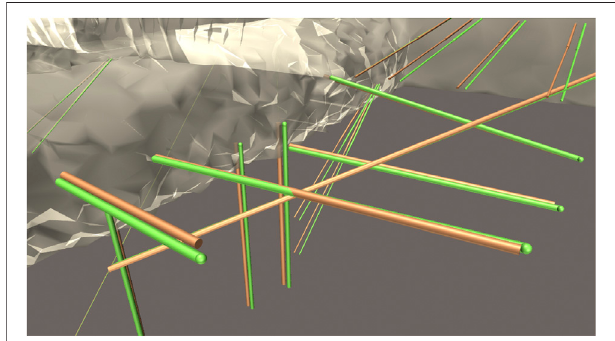
FIGURE3| Visualrepresentationoftheboreholesbasedoncalculations with single-precision fl oating-point vectors (brown) compared to double- precision (green). The green spheres are marking the actual borehole ’ s start- and end point as a reference for